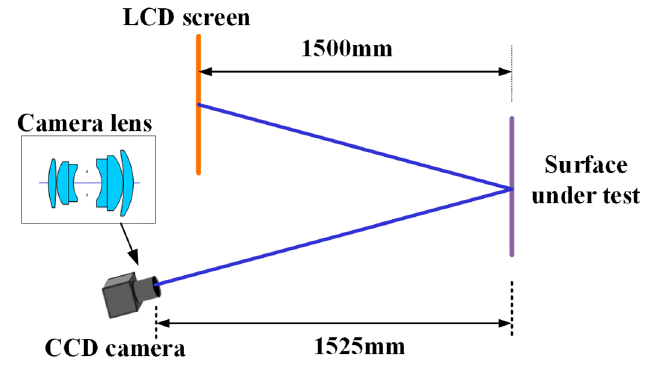
Figure 5. Schematic diagram of PMD.